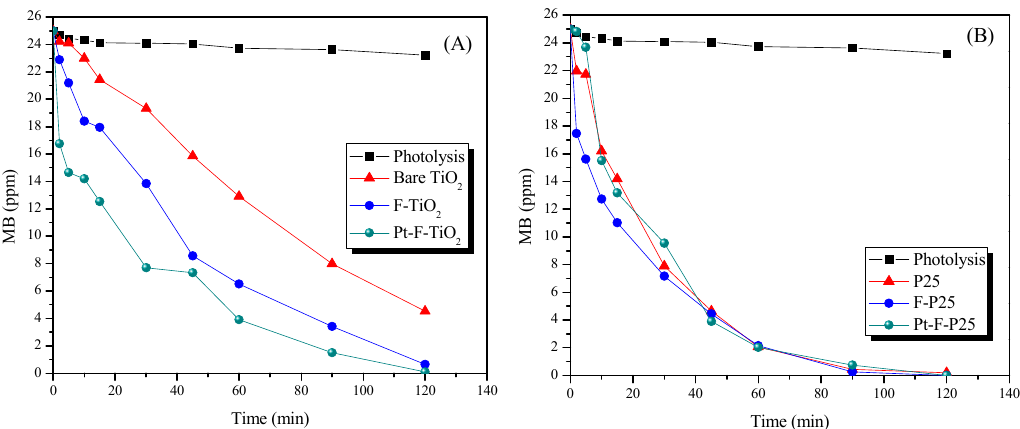
Figure 9. Evolution of MB concentration with the photoreaction time over the photocatalysts analyzed. ( A ) Lab prepared TiO 2 modified and ( B ) Commercial TiO 2 modified.